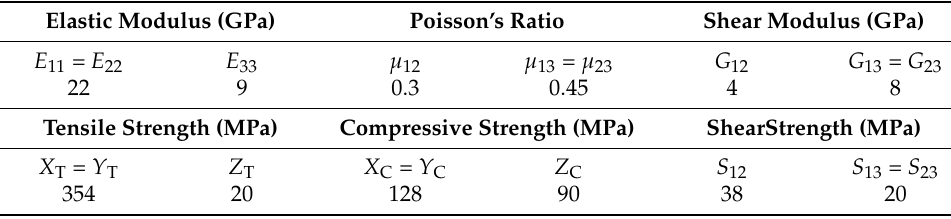
Table 2. Mechanical parameters of the glass fiber reinforced polymer (GFRP).